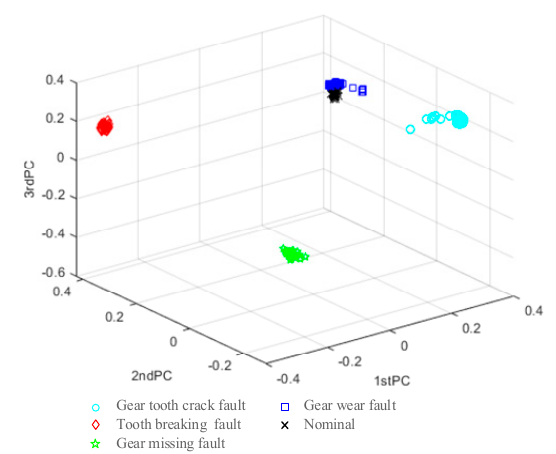
Figure 14. Clustering result of wavelet entropy under condition 4.